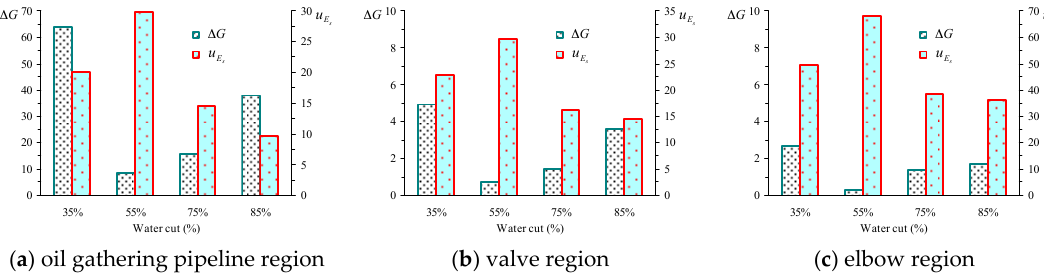
Figure 10. Effect of water cut on shearing energy and interfacial Gibbs free energy change.